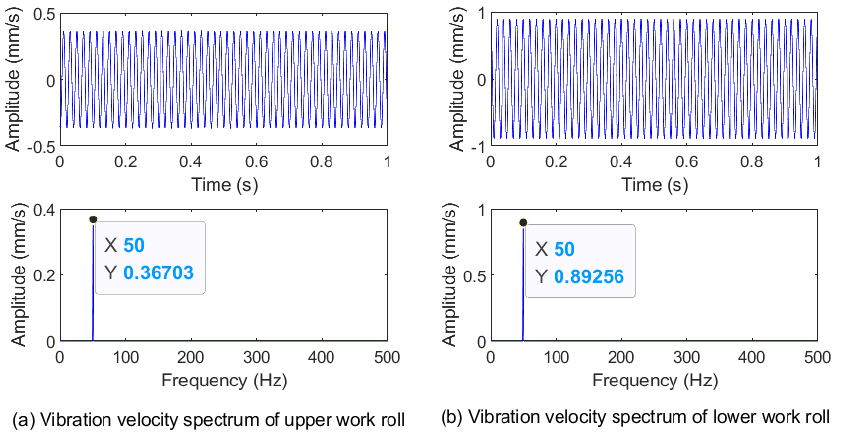
Figure 7. Rolling mill vibration spectrum at C = 1, f = 50 Hz.